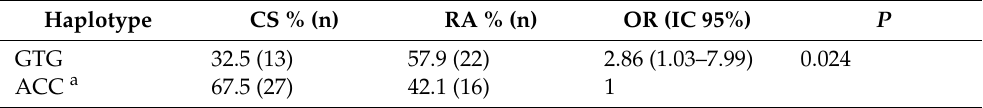
Table 3. Distribution of the PADI4 gene haplotypes